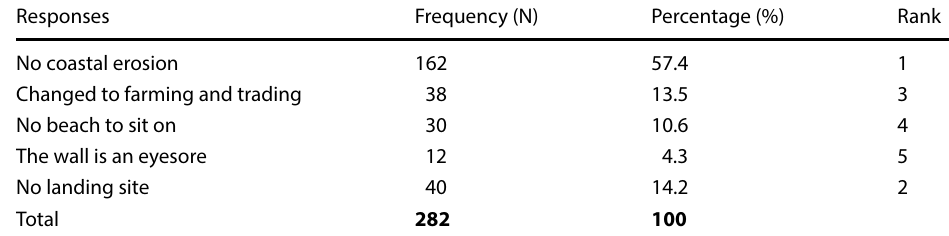
Table 3 Adaptation strategies to coastal flood defence